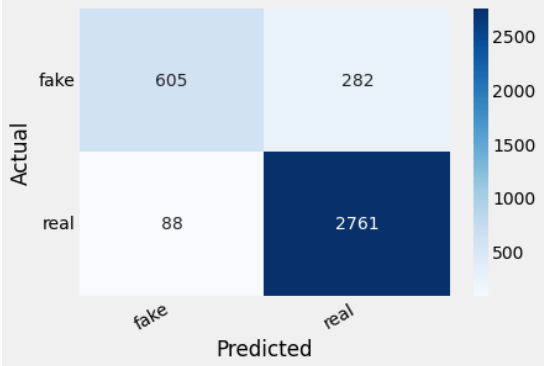
Figure 10. Confusion matrix of BERT base -CNN-BiGRU in GossipCop.